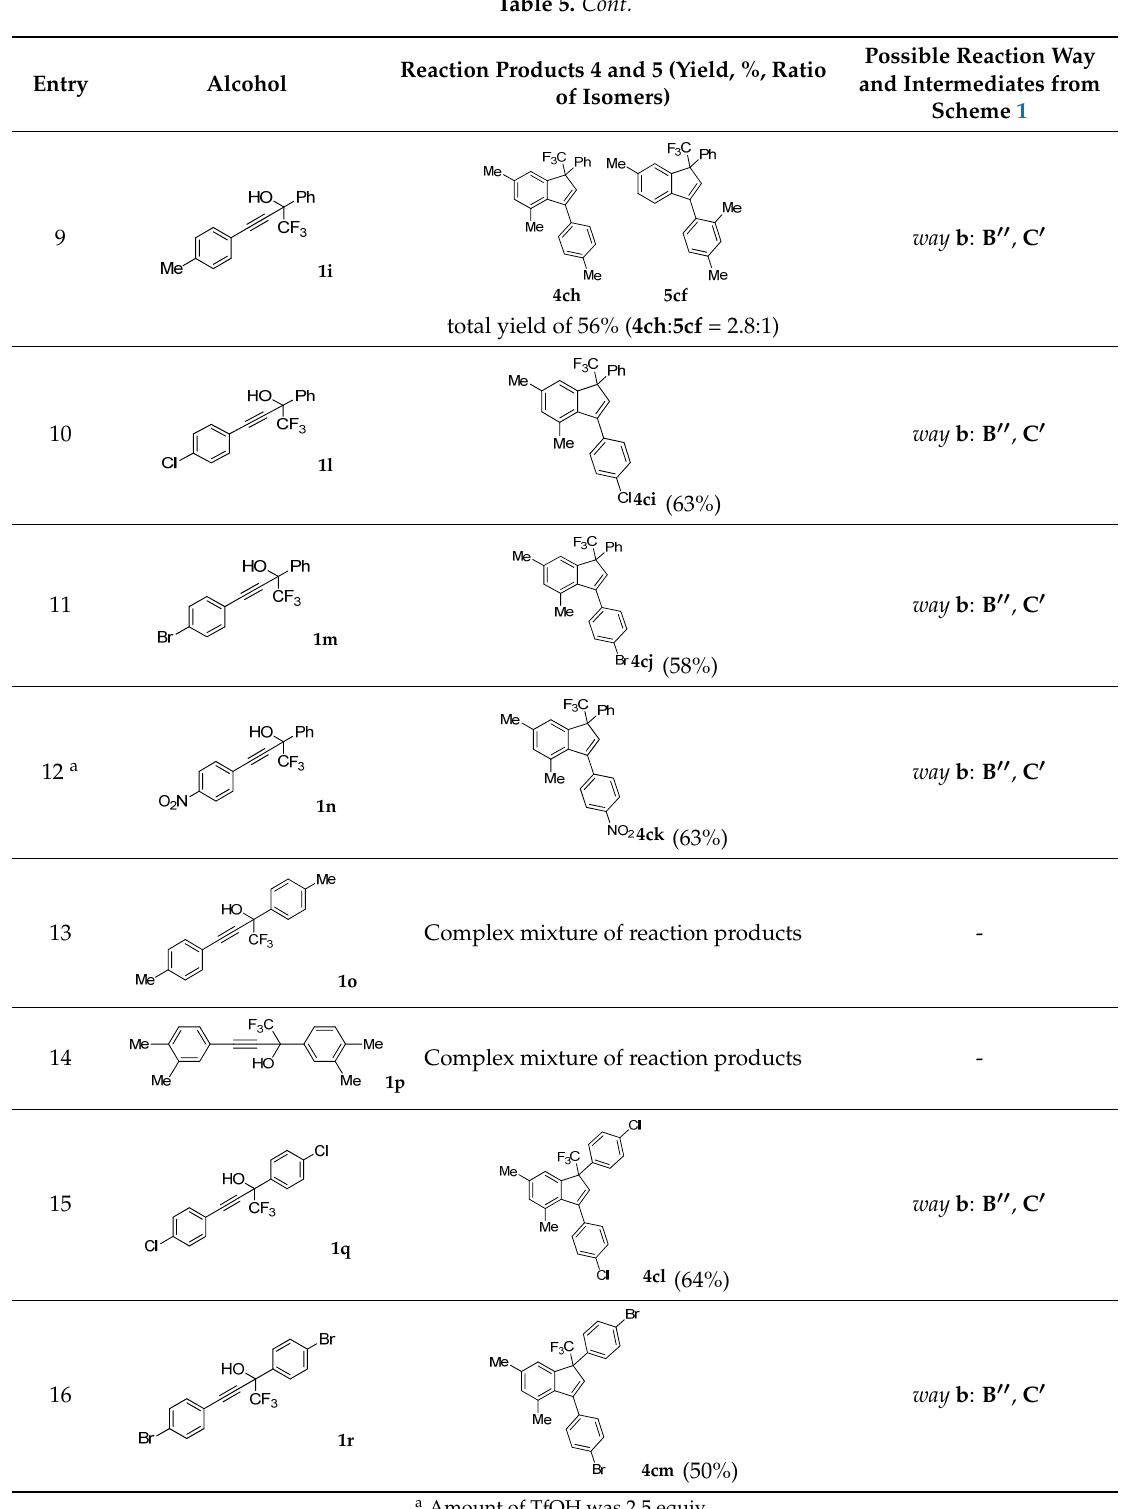
Table 6. TfOH-promoted reaction of 1 with pseudocumene; reaction conditions: TfOH, CH 2 Cl 2 , molar ratio of 1 :pseudocumene:TfOH = 1:1.1:1.5, room temperature, 1 h.